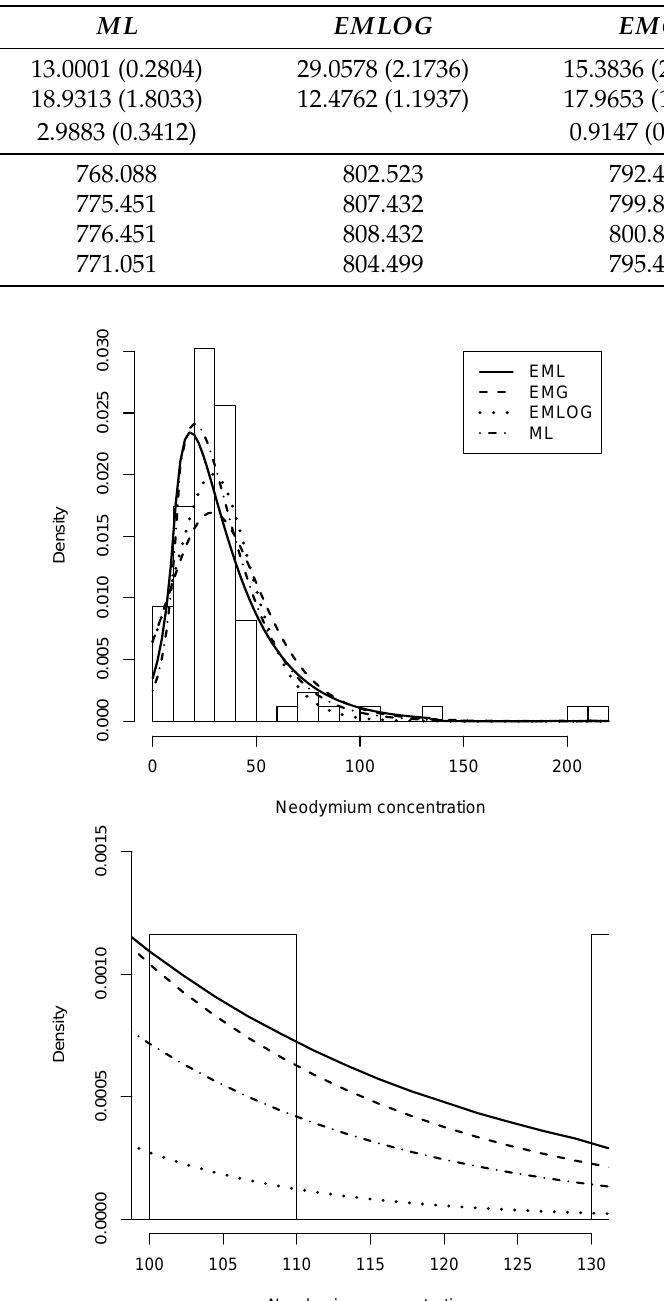
Figure 7. Histogram ( upper ) and tail ( lower ) for the neodymium concentration data set. The first graph shows the densities of the exponentially modified Laplace (solid line), Gaussian modified exponentially (dashed line), exponentially modified logistic (dotted line), and modified Laplace (dash-dotted line) distributions, with their parameters estimated by